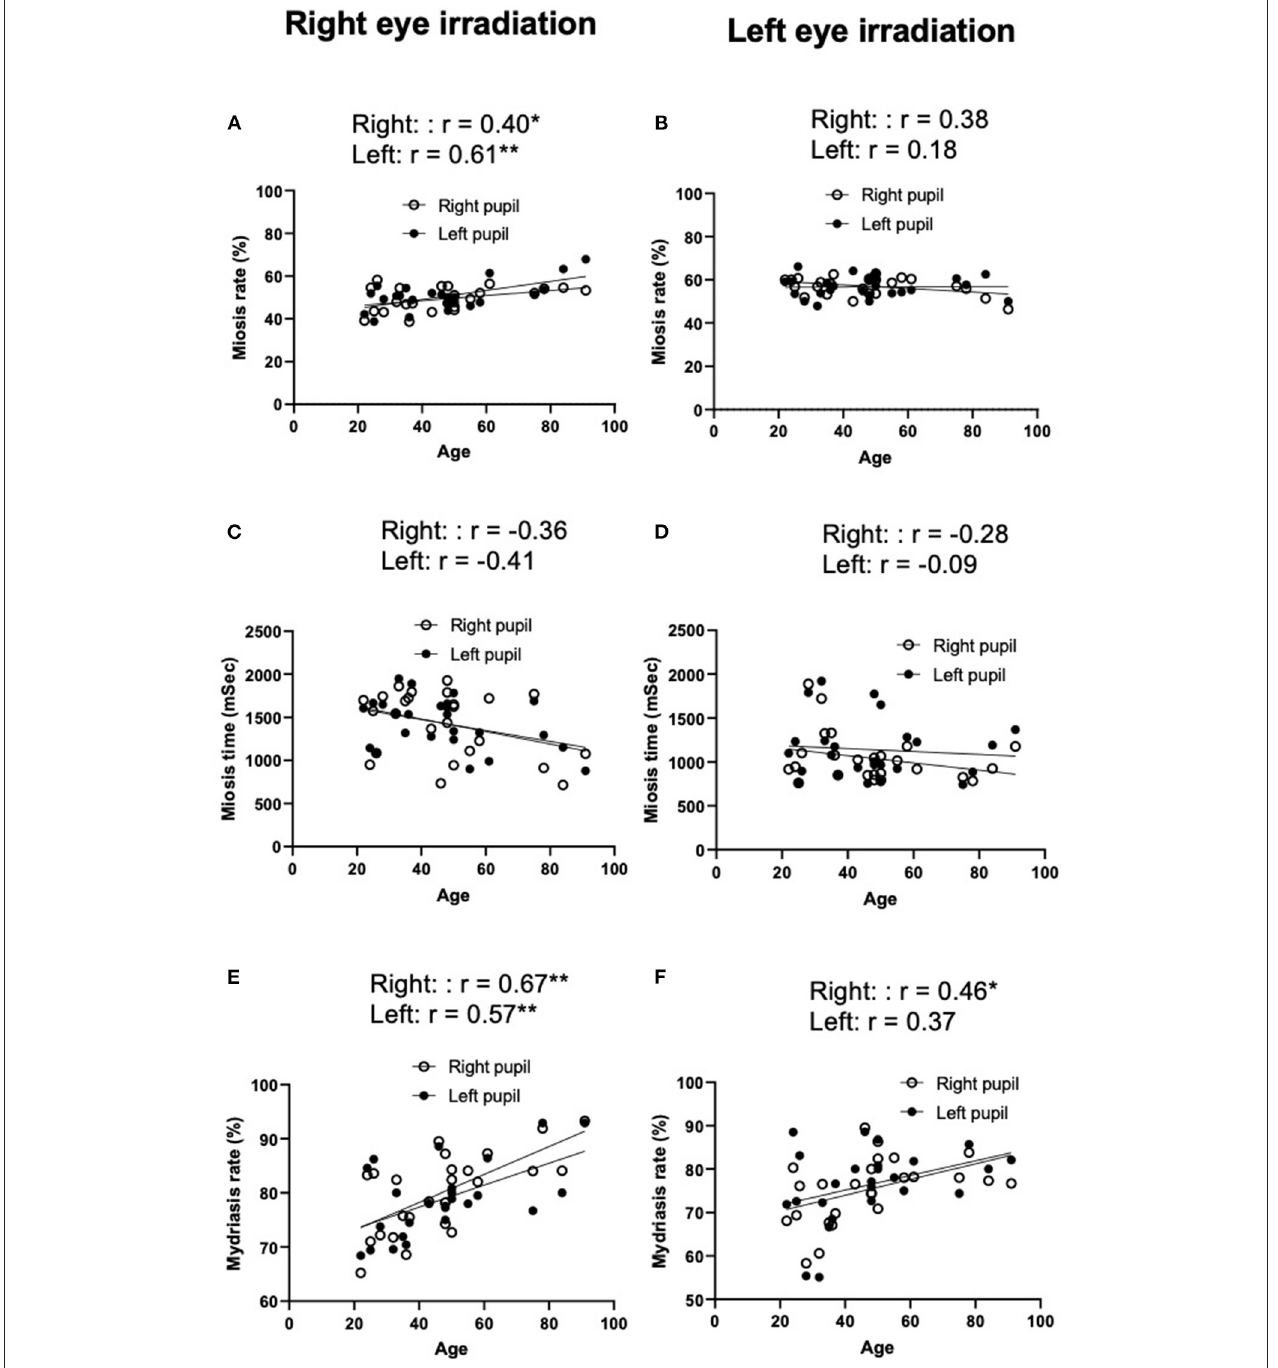
FIGURE 5 | Relationship between age and miosis rate (A,B) , miosis time (C,D) , and mydriasis rate (E,F) in healthy volunteers. r , correlation coefficients. ** P < 0.01, * P < 0.05. N = 25/group.